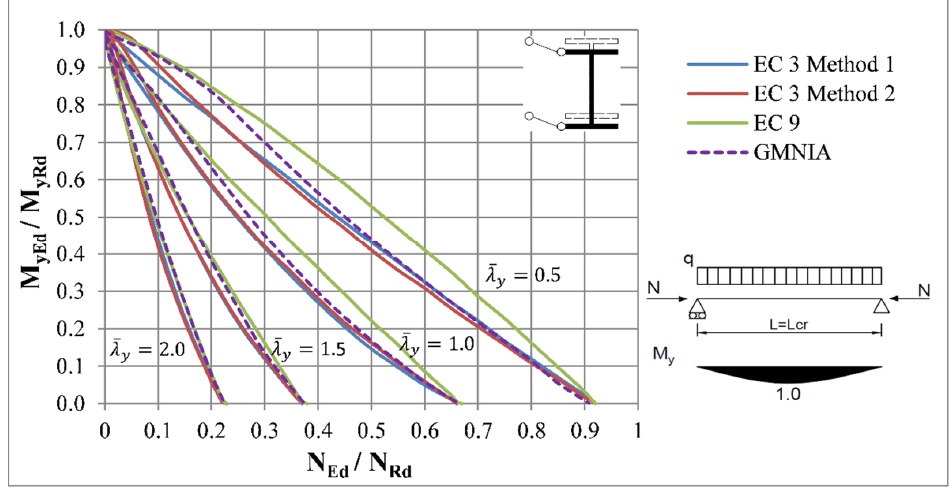
Figure 10. Interaction curves for laterally restrained beam-columns with IPE 100 cross-section.